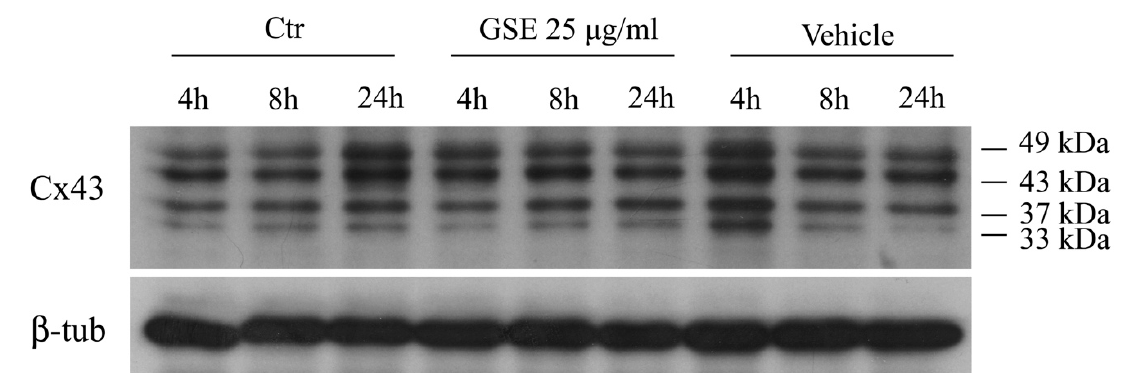
Figure 6. Western blot analysis of Cx43 protein. MCF-7 cells were incubated with 25 µ g / mL GSE for 4, 8 and 24 h, and 15 µ g of extracted proteins were separated by SDS–polyacrylamide gels and transferred onto nitrocellulose membranes. The membranes were probed with the anti-Cx43 antibodies and ECL detection. Beta-actin was used as a control.